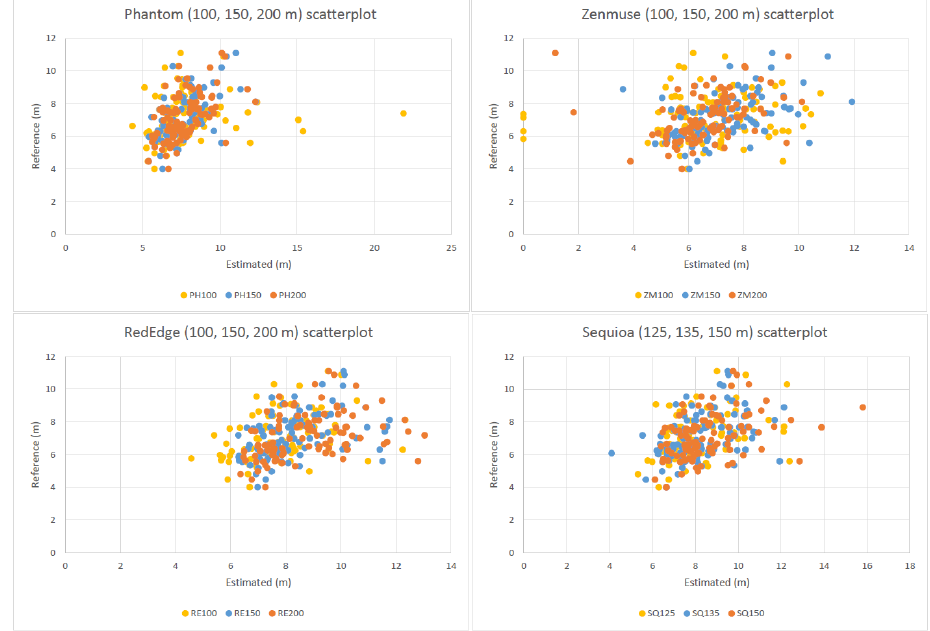
Figure A1. Scatterplots showing the association between the manually and automatically delineated tree crowns — examples from Site I.